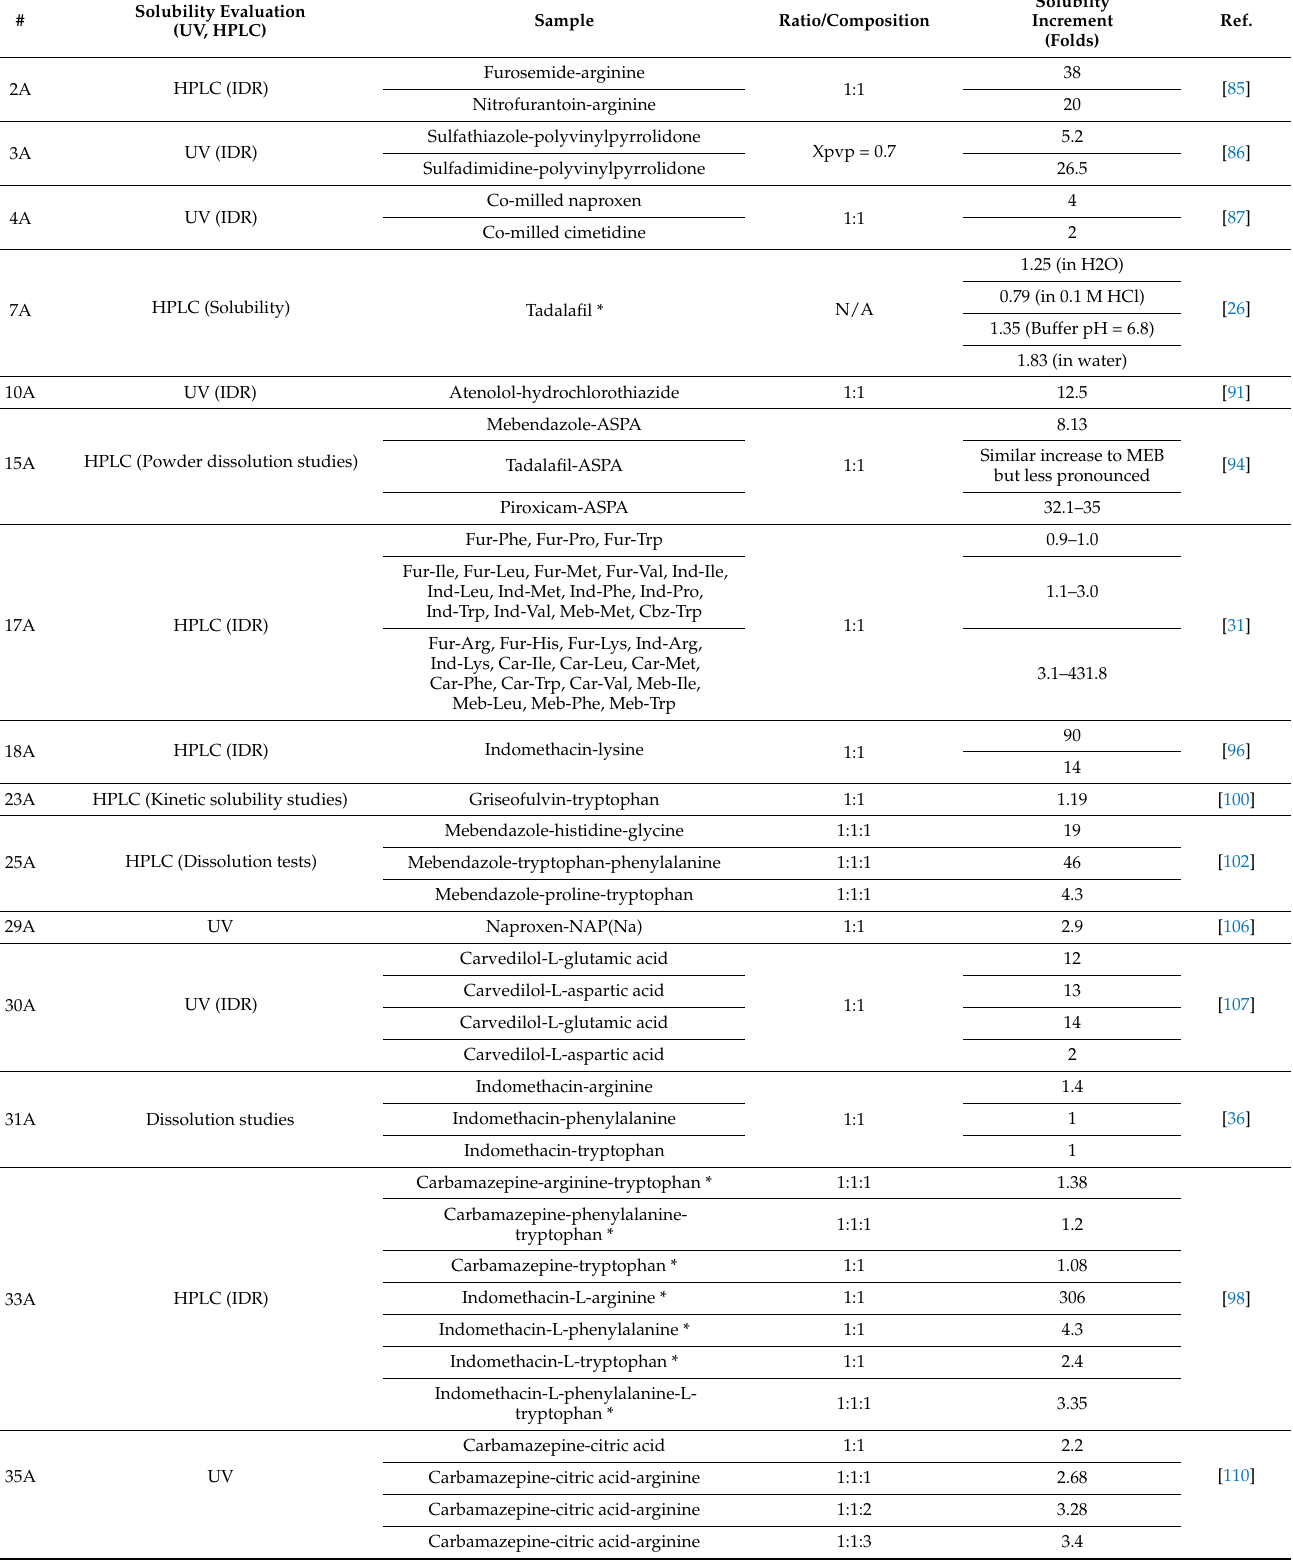
Table 4. Overview of solubility enhancement of amorphous systems prepared by ball